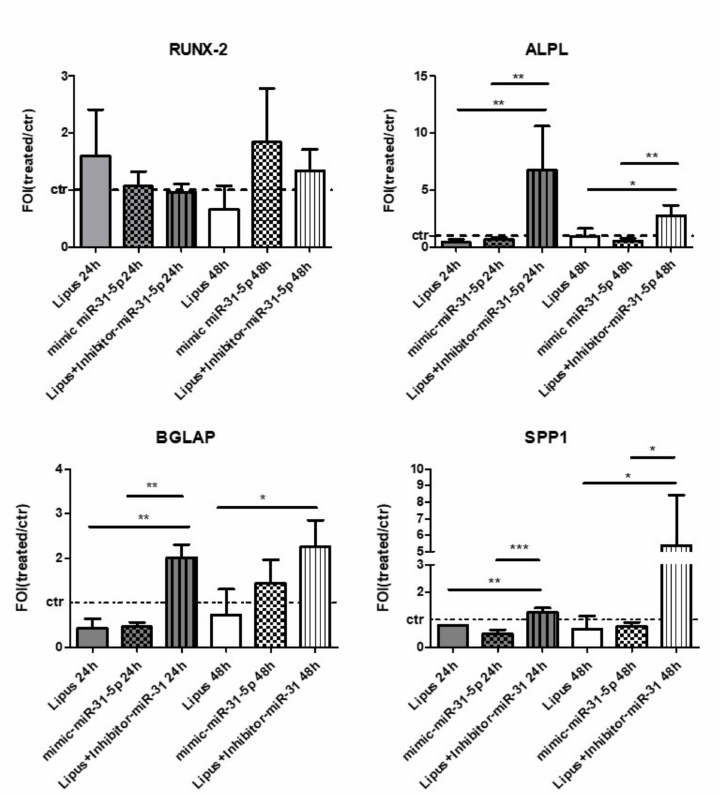
Figure 7. Analysis of osteoblast markers expression, RUNX-2 and ALPL; BGLAP and SPP1, after LIPUS stimulation or miR-31-5p mimic or miR-31-5p inhibitor or negative scramble expression after 24h or 48 h of treatment mean ± SD. Quantitative RT-PCR data are expressed as fold of change (FOI) in gene expression (2 − ∆∆ C t ) and occurred in treated groups respect to untreated group. Tukey HSD post hoc comparison test: *, p < 0.05; **, p < 0.005; ***, p <